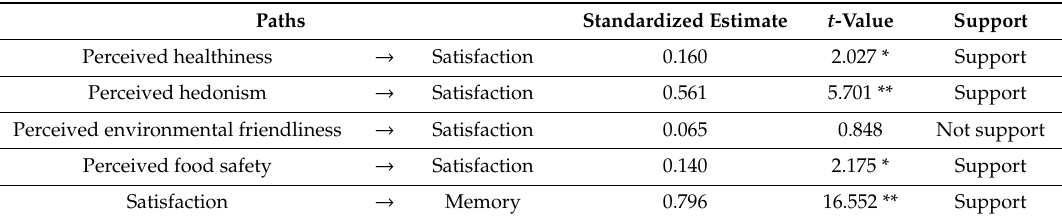
Table 5. Standardized coe ffi cients.